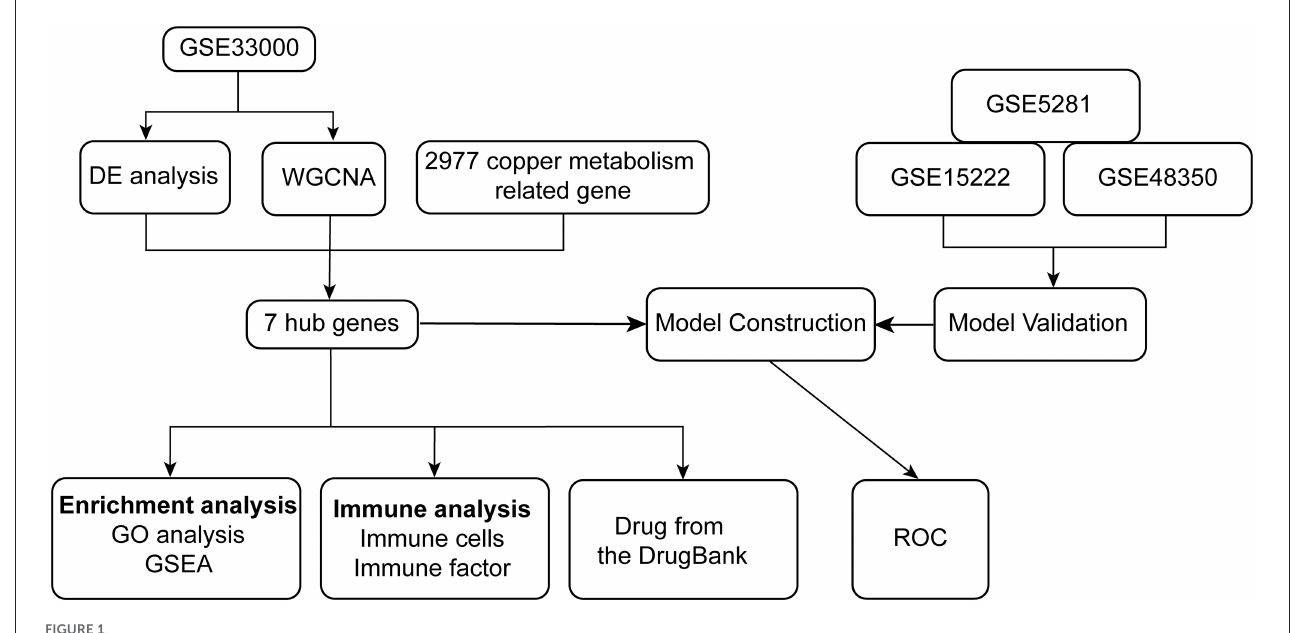
FIGURE1 The flowchart of the